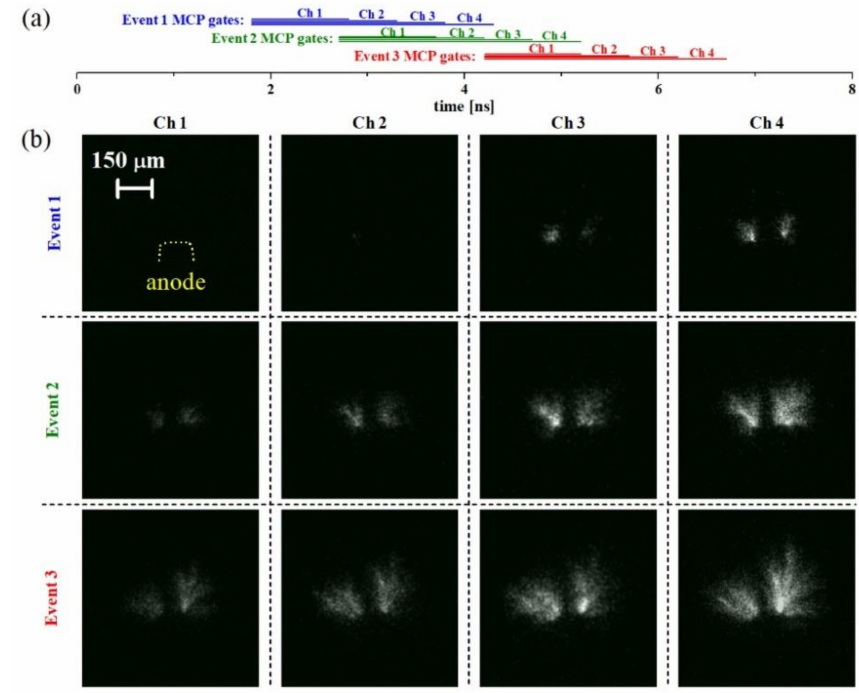
Figure 9. Case study B; image sequences obtained with the discharge emission that passes through the λ c = 532 nm interferential filter. Horizontal bars in ( a ) labelled as Ch1–Ch4 illustrate the timing of the Ch1–Ch4 MCP gates with respect to the onset (time t = 0 ns) of the HV pulse. Images in panel ( b ) show the evolution of selected events during the primary HV pulse acquired by using the Ch1, Ch2, Ch3, and Ch4 MCP gates of 1, 1.5, 2, and 2.5 ns,